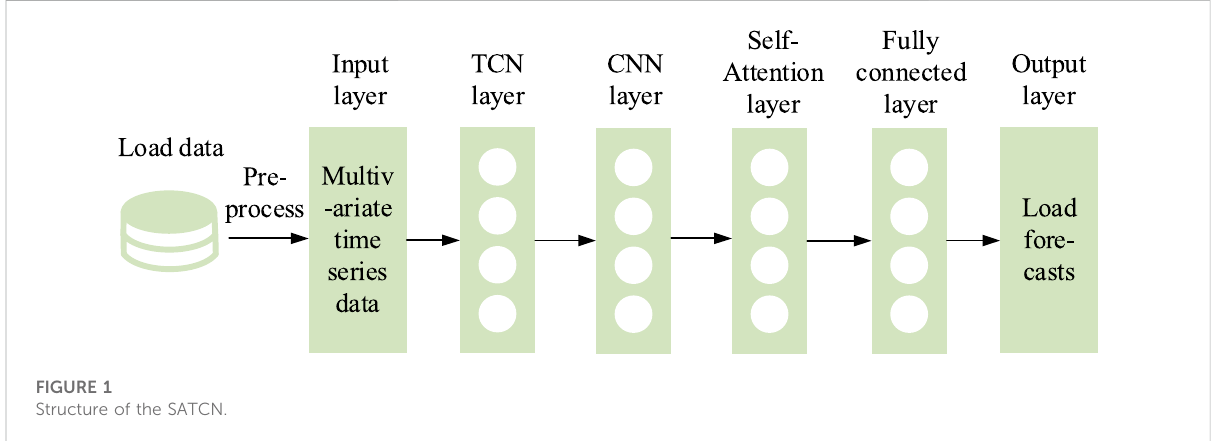
FIGURE 1 Structure of the